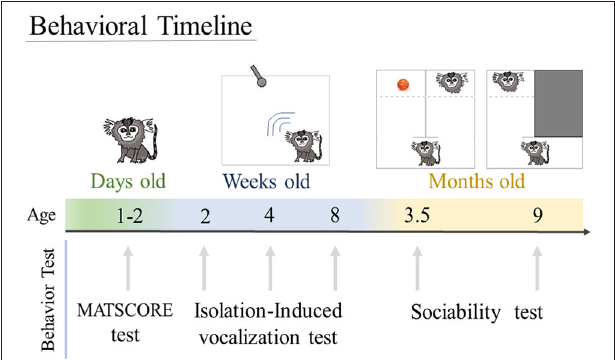
FIGURE 1 | Behavioral timeline. Animals were tested to assess motor and sensory skill in the MATSCORE test when they were 1 to 2 days old. Isolation-induced vocalization test was performed when the infants were 2, 4, and 8 weeks of age. Sociability test was done at 3.5 and 9 months of